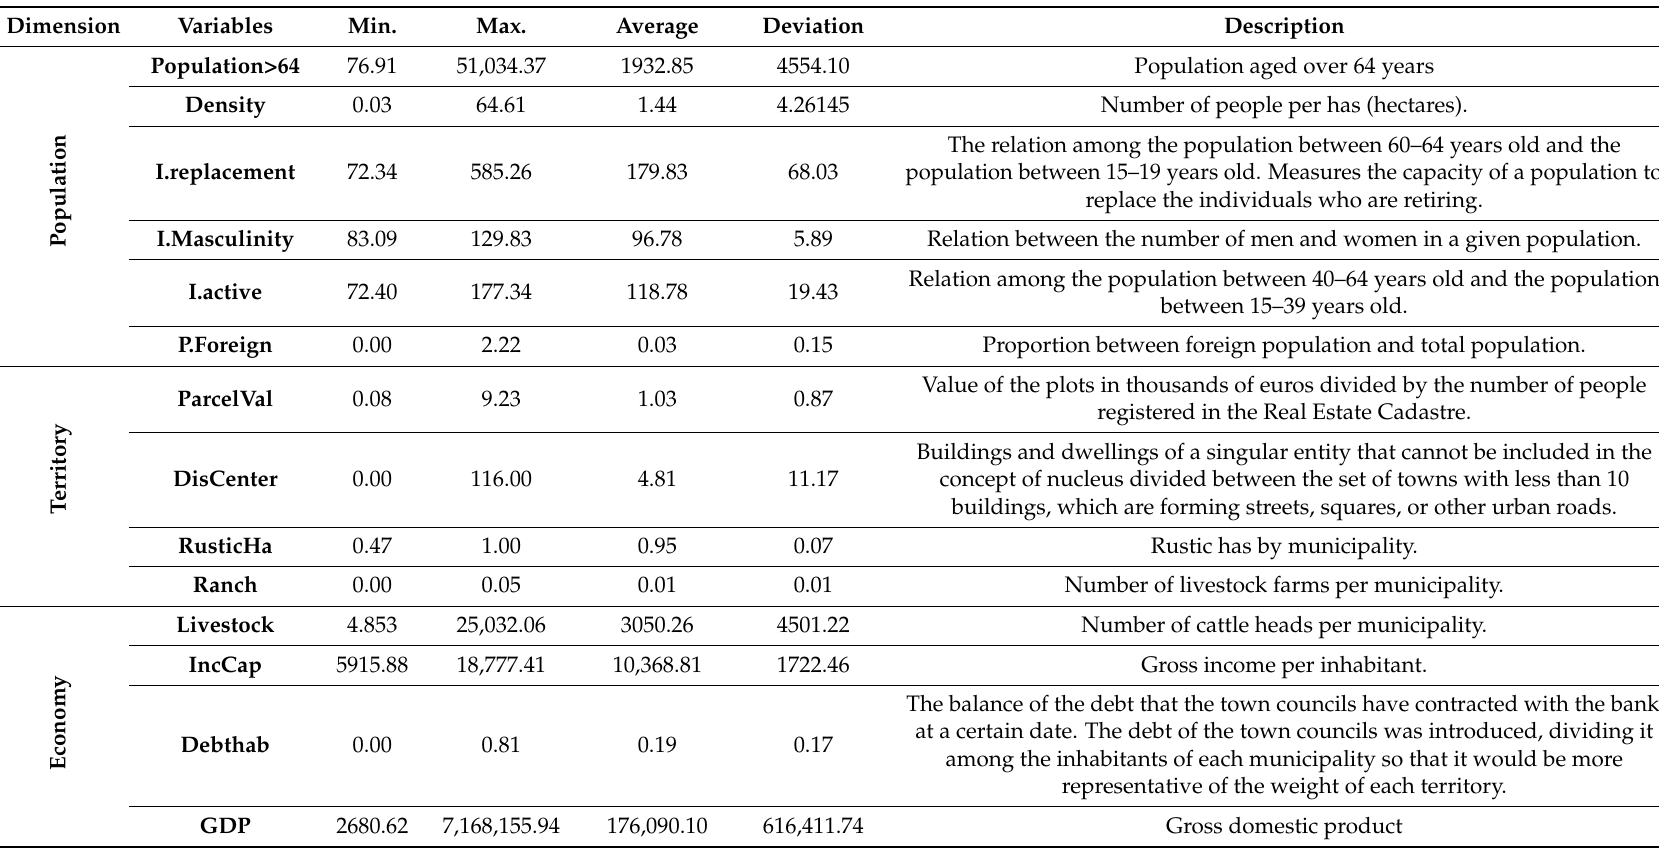
Table 1. Variables: description and definition. Source: Own elaboration from the Galician Statistics Institute (IGE).